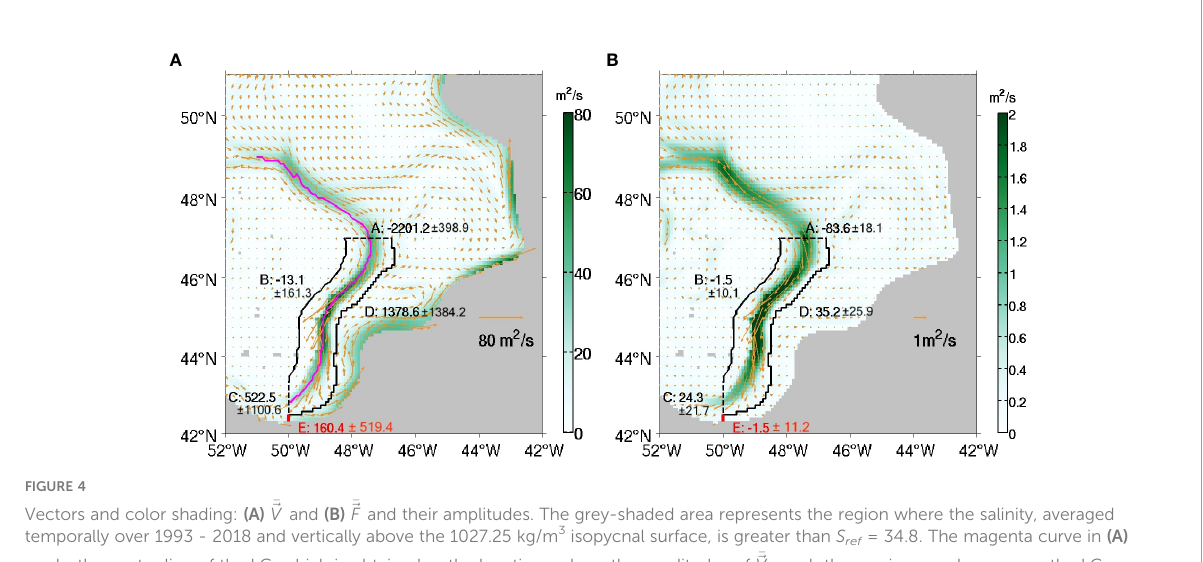
(cid:1) ~ V reach the maximum values across the LC. (cid:1) ~ V (cid:1) ~ F and along these sections with the units of